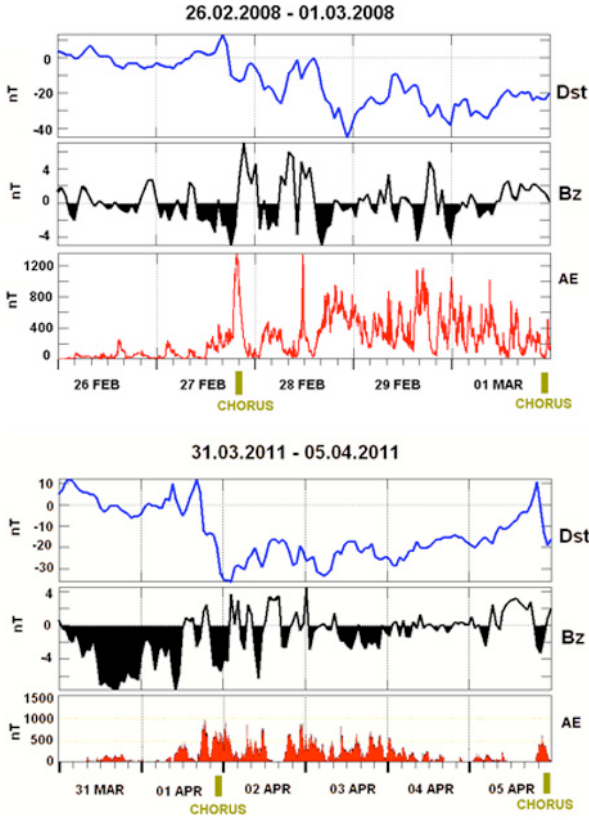
Fig. 7. Geomagnetic conditions in the intervals of night cho- rus bursts in 2008 and 2011; from top to bottom: variations of Dst-index, IMF B z component and AE-index for 26 February– 1 March 2008 (upper panel) and 31 March–5 April 2011 (bottom